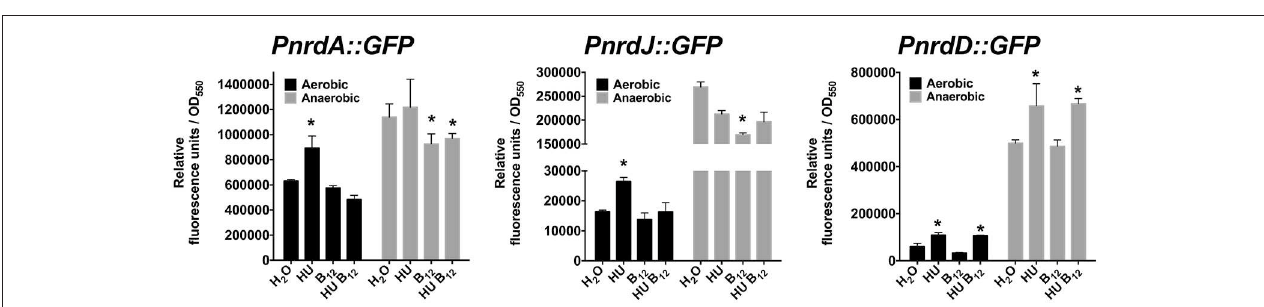
FIGURE 1 | Effect of hydroxyurea and vitamin B 12 on P. aeruginosa PAO1 wild-type, 1 nrdJ , 1 nrdD , 1 nrdJ 1 nrdD, and 1 cobN strain growth. Five-microliter drops were plated from a 0, 10 − 4 , and 10 − 8 dilution into a solid medium containing 30mM hydroxyurea (HU) and 1 µ g/ml vitamin B 12 (vit B 12 ) for 48h. Pictures represent three independent experiments.